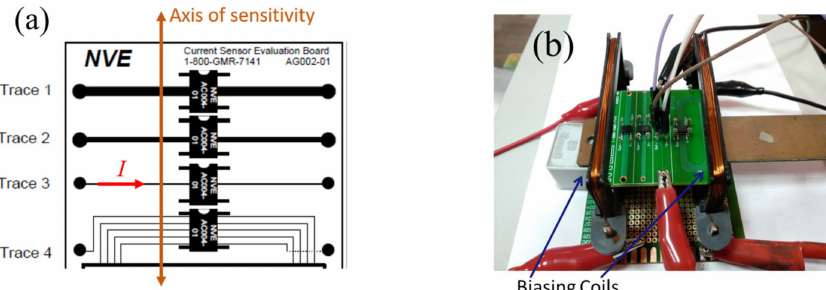
Figure 6. ( a ) Schematic of the evaluation board. The current trace 3 (w = 0.254 mm) was used for tests; ( b ) image of the experimental setup used for GMR current sensing.